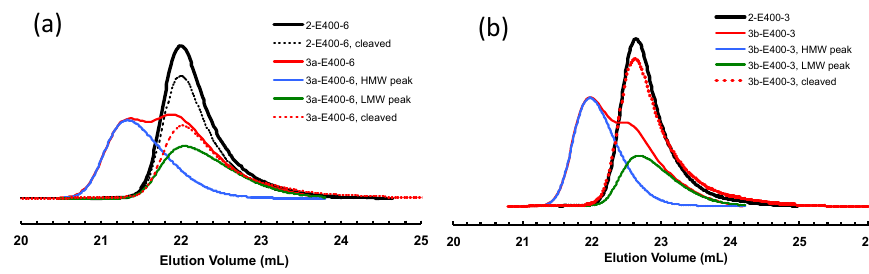
Figure 9. Comparison of GPC elution curves of polymer samples before and after cleavage: ( a ) samples 2-E400-6 and 3a-E400-6; and ( b ) samples 2-E400-3 and